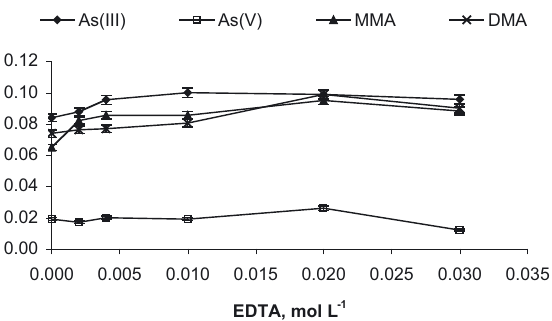
Figure 1. Influence of EDTA concentration on generation of arsines. HCl concentration in the acid channel 1.2 mol L -1 HCl. Sample preparation – EDTA added to standard solutions (pH